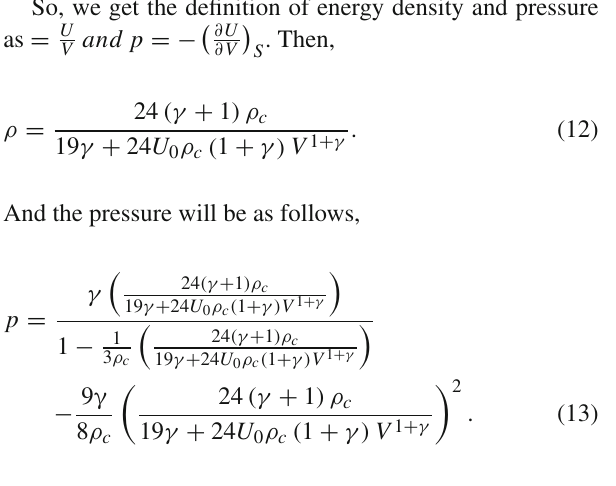
Fig. 4 Graph for EOS parameter; w = − 2 − 5 ; τ = − 0 . 05